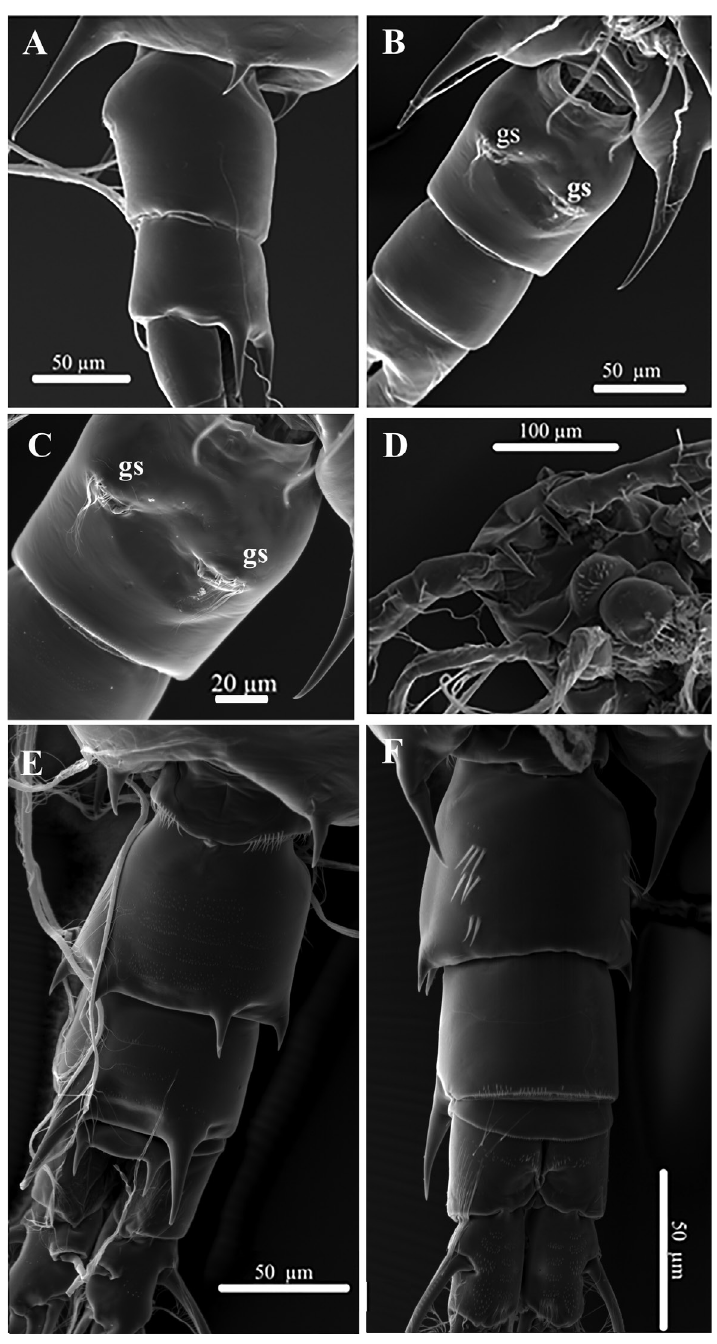
Figure 5. SEM micrographs of Acartia ( Odontacartia ) edentata , sp. n., female ( A–D ) and male ( E, F ) A The genital double-somite lateral view B Urosomite, ventral view C Genital double-somite, ventral view D Rostrum, ventral view E Urosomite, dorsal view F Urosomite, ventral